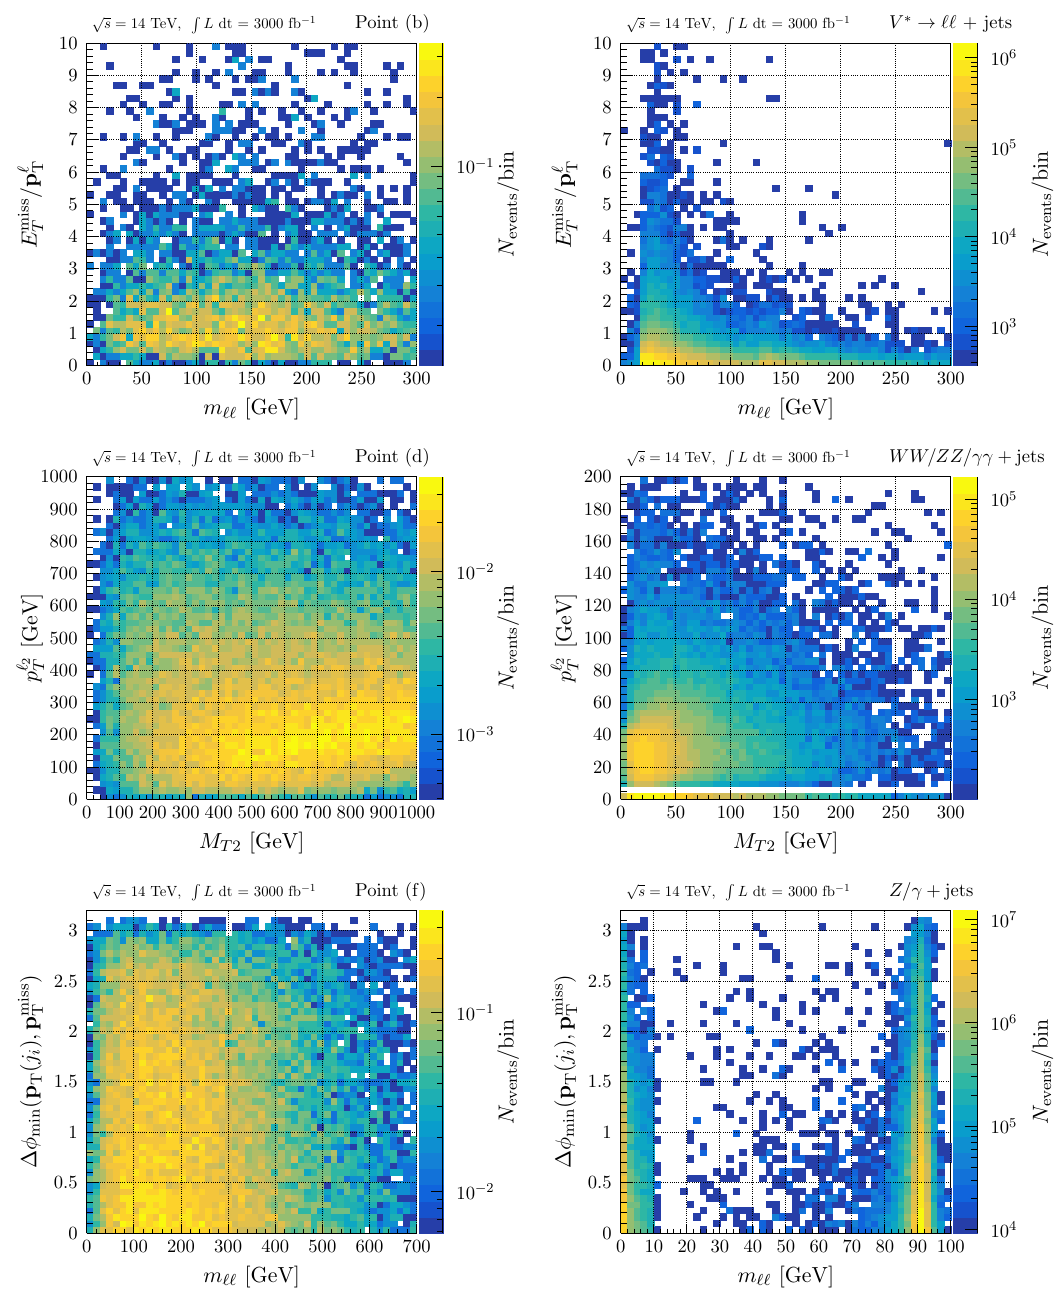
Figure 4 . Two dimensional plots in select kinematic variables with the number of events on the color axis. Top panels: E miss / p ‘ vs the dilepton invariant mass for benchmark (b) (left) and T T off-shell vector boson background (right). Middle panels: the subleading lepton transverse mo- mentum vs M T 2 for benchmark (d) (left) and the diboson background (right). Bottom panels: ∆ φ min ( p ( j i ) , p miss ) vs the dilepton invariant mass for benchmark (f) (left) and Z/γ + jets back- T T ground